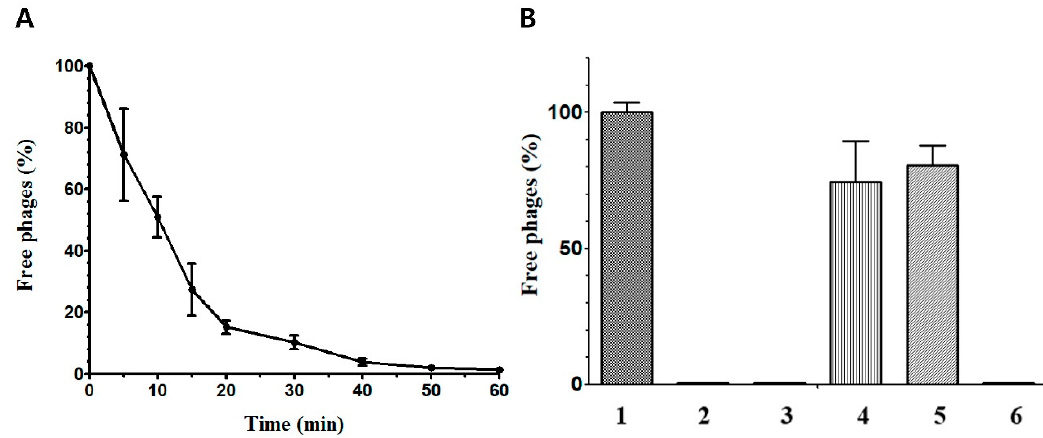
Figure 2. CPS1 binds to polysaccharides on the cell surface. ( A ) CPS1 adsorption assay with ATCC 13124. CPS1 was infected at 30 ◦ C. It was found that 95% of CPS1 adsorbed in 40 min. ( B ) CPS1 adsorption assay with various treatment. 1: BHI (No cells), 2: untreated cells, 3: acetate treatment, 4: 10 mM periodate treatment, 5: 100 mM periodate treatment, 6: proteinase K treatment.